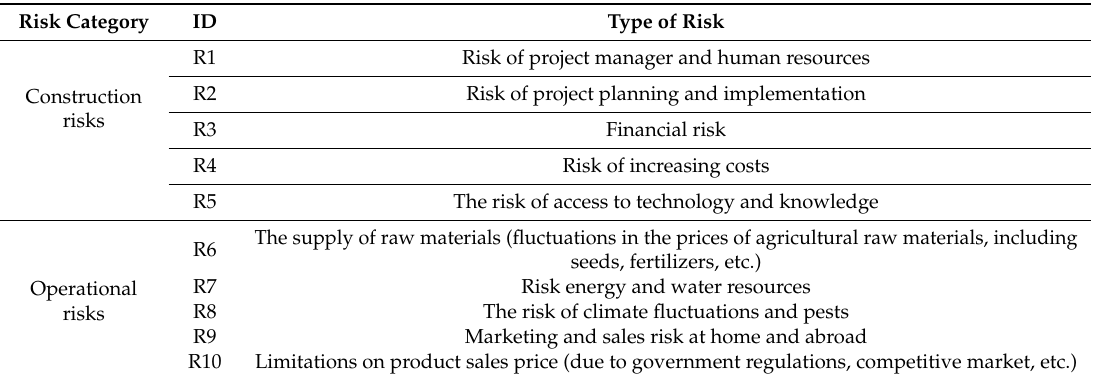
Table 3. Identification and categorization of investment